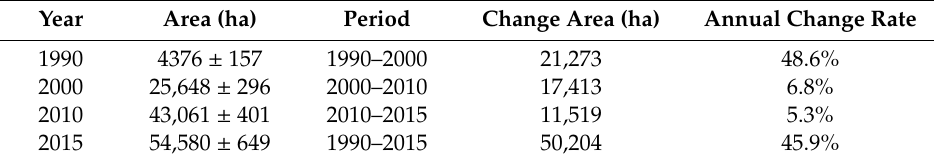
Table 1. Areas and changes in Spartina alterniflora over the investigated 25 years.